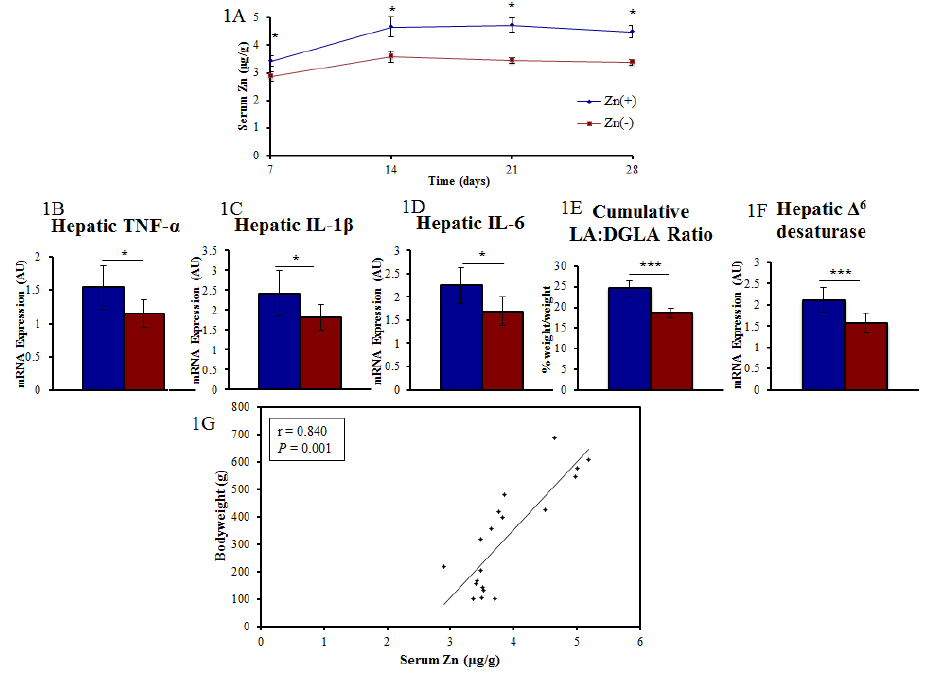
Figure 1. Measured Zn status parameters. ( A ) Day 7, 14, 21, and 28 serum Zn levels were significantly different between treatment groups ( n = 12, * p < 0.05, ANOVA); ( B – D ) mRNA gene expression of hepatic tissue excised at the conclusion of study ( n = 12, day 28, * p < 0.05, ANOVA); ( E,F ) Additional Zn biomarkers utilizing erythrocyte fatty acid composition (*** p < 0.001, n = 12); ( G ) Linear correlation between bodyweight and serum Zn on day 28.